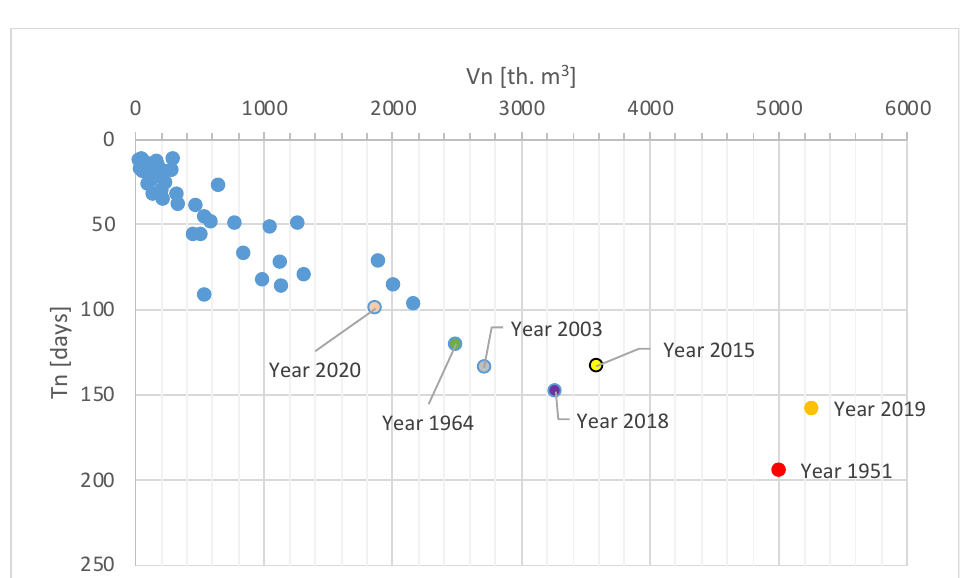
Figure 16. Maximum intensity of summer droughts and lowest discharge of summer droughts in the hydrological years 1951–2020 in the Narewka River to Narewka gauging profile.